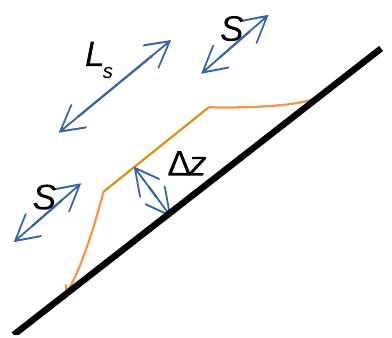
Figure 2. Side view of the submarine slide. L s is length, S the smoothing distance in front and rear and ∆ z its maximum